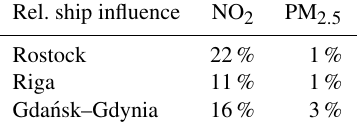
Table 4. Summary of shipping impact on NO 2 and PM 2 . 5 concen- trations as total annual averaged grid mean for the total domains in 2012. Rel. ship influence NO 2 PM 2 .